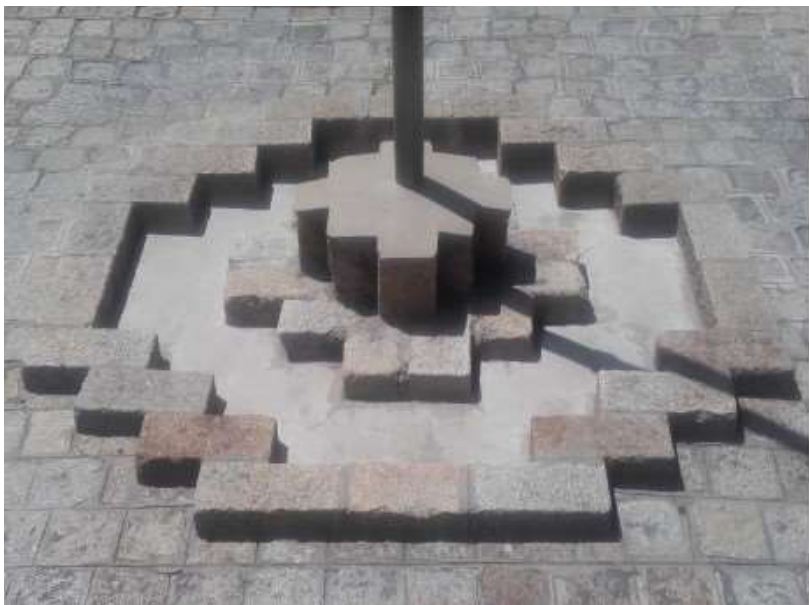
Figure 1: National Museum of Archaeology (MUNARQ) in La Paz-Bolivia, representation of the Chakana . Photography by Yaneth K. Apaza Huanca.